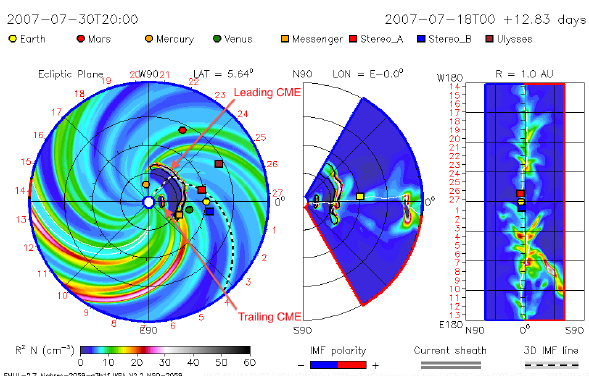
Fig. 1. The CCMC’s ENLIL with a cone model simulation results. The estimated arrival time of the leading partial halo CME at Venus is approximately 20:00 on 30 July 2007 using the above simulation results. The red arrows mark the leading and trailing CMEs.